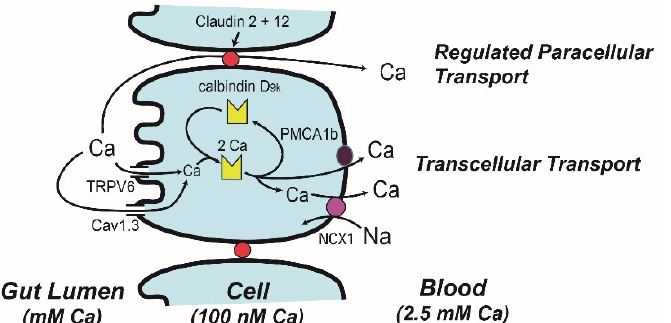
Figure 3. A Model describing intestinal calcium (Ca) absorption. The transcellular absorption pathway is described by the facilitated diffusion model while a regulated paracellular transport mechanisms mediated by claudin 2 and claudin 12 provides selectivity for Ca movement through the tight junction complex. For details of how vitamin D regulates various aspects of these models refer to the text.